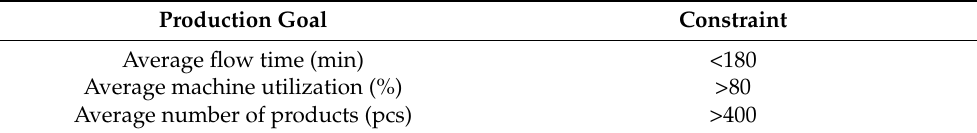
Table 4. Constraints for optimization